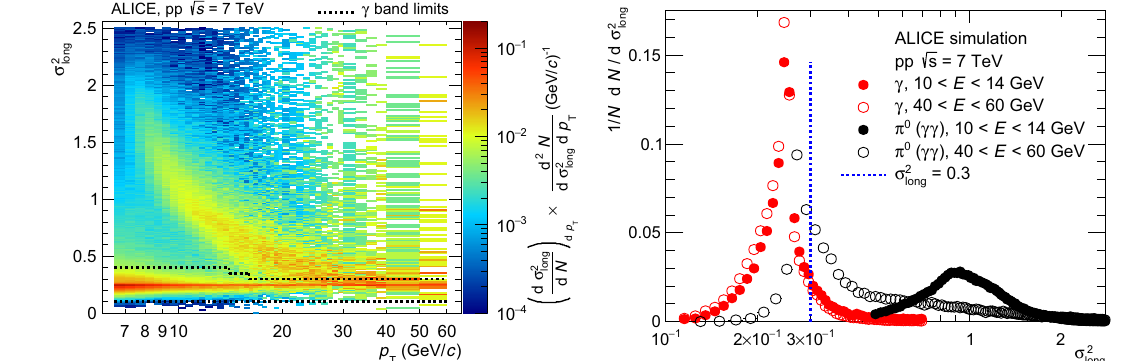
Fig. 2 Left: Shower shape parameter σ 2 versus neutral cluster p T . different cluster energies from PYTHIA 6 γ -jet and jet-jet simulations long The band limited by the black dashed lines indicates the area popu- with GEANT3 tuned for cross-talk emulation. A line at σ 2 lated by single photons and defines the photon selection cuts (narrow represents the cut used to select narrow clusters at p clusters) used in the analysis. Right: Distributions of the shower shape distributions are normalised to an integral of 1. In the left plot each p T parameter for different types of clusters produced by single photons bin is separately normalised to 1 (red bullets) or overlapped photons from π 0 decays (black bullets) for